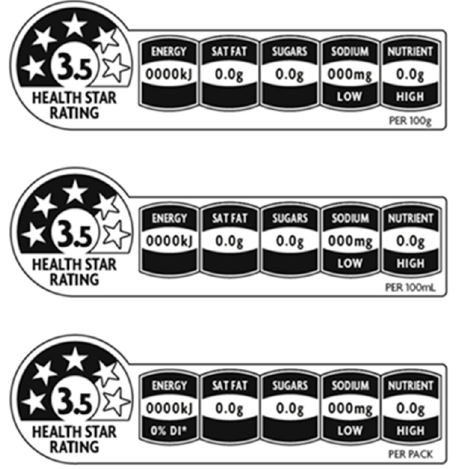
Figure 1. Health Star Rating nutrition label [30].